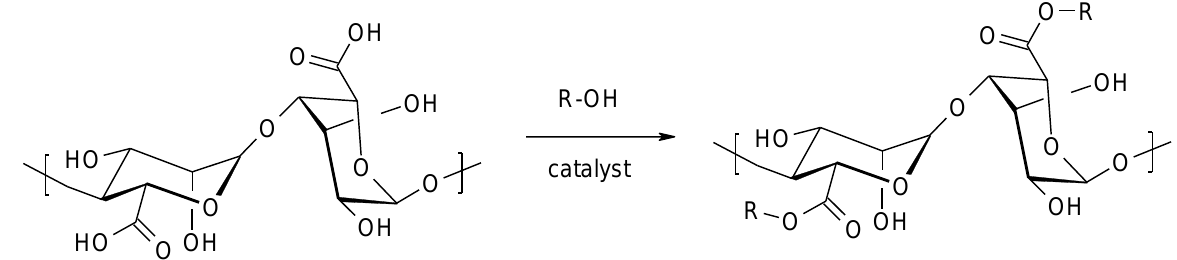
Figure 14. Esterification of alginates with alcohols.